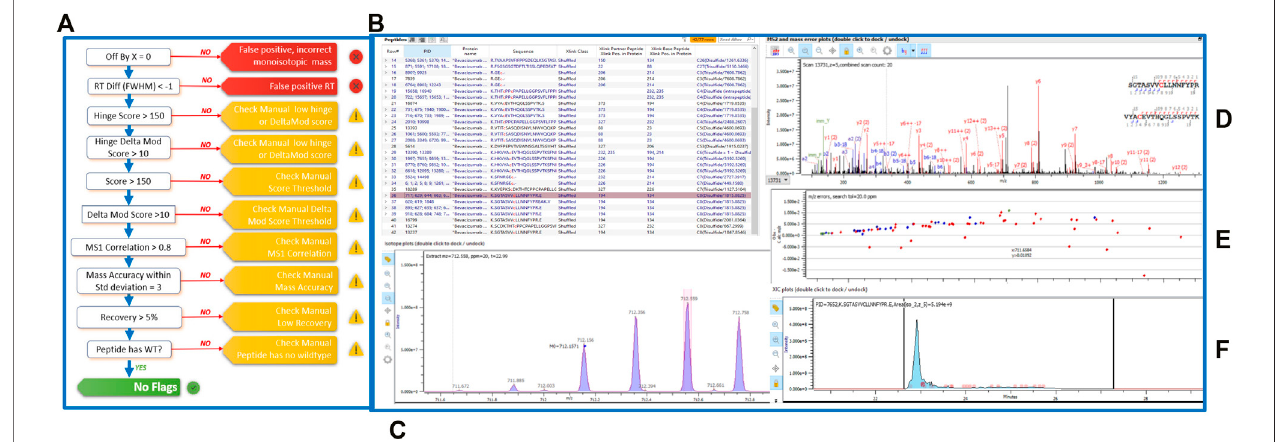
FIGURE 2 | (A) Schematic of the Byos disul fi de bond work fl ow. (B) Highlighted bevacizumab shuf fl ed disul fi de bond used for representation of LC-MS/MS data plots. Generated data depicted as a (C) MS1 plot; (D) MSMS plot; (E) Mass error plot; and (F) XIC intensity